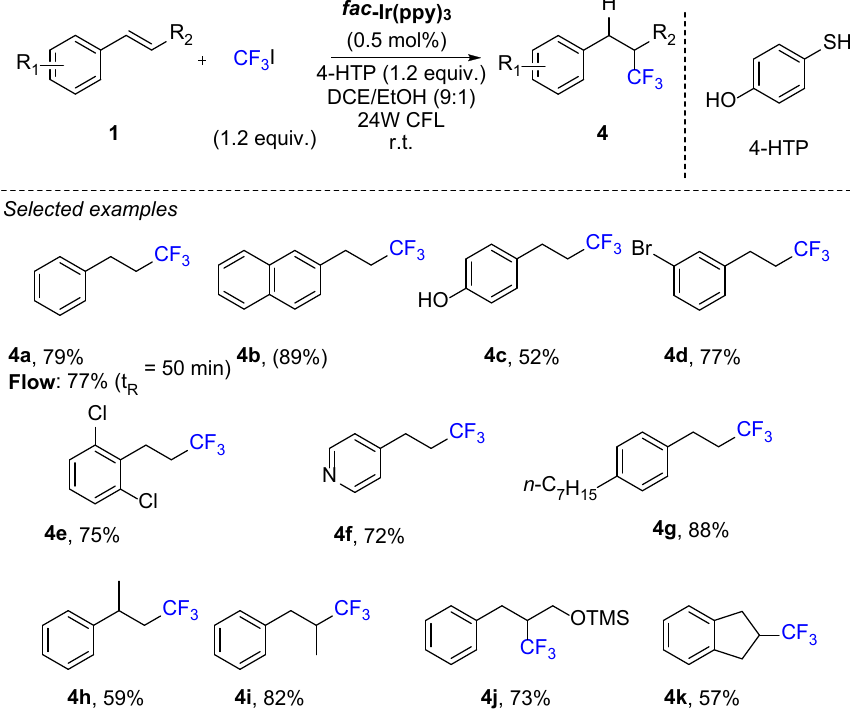
Figure 2. Hydrofluoroalkylation of styrenes developed by the group of Noel.